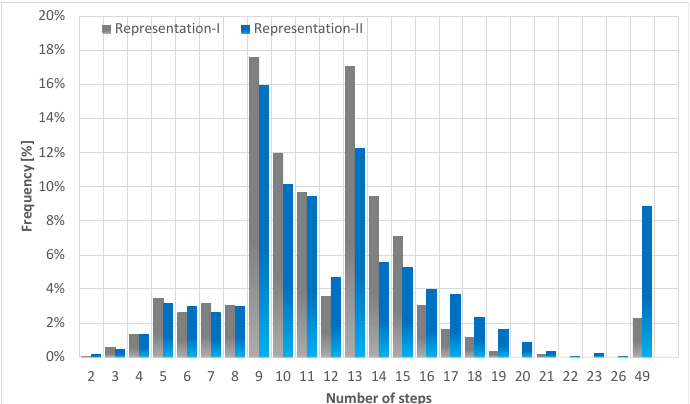
Figure 8. Comparison of the different solutions for the original network.